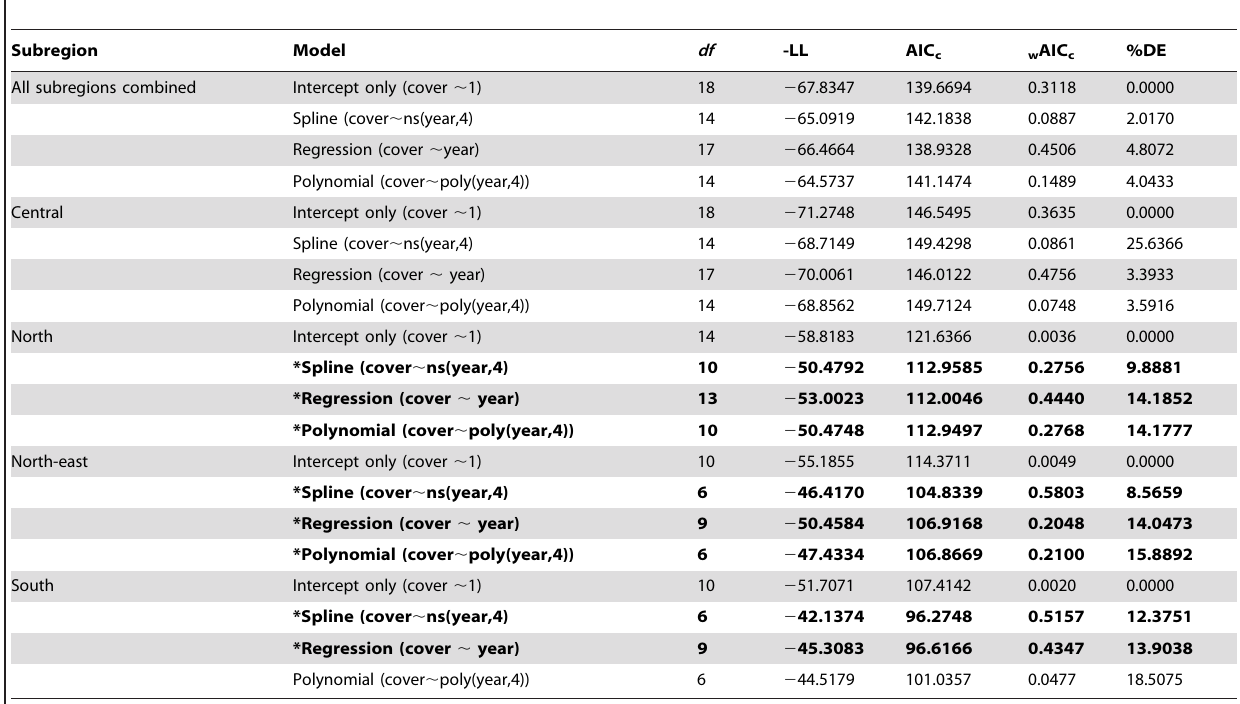
Table 2. Model ranking results of relationship between coral cover over time for sub-regions at Ningaloo Reef.